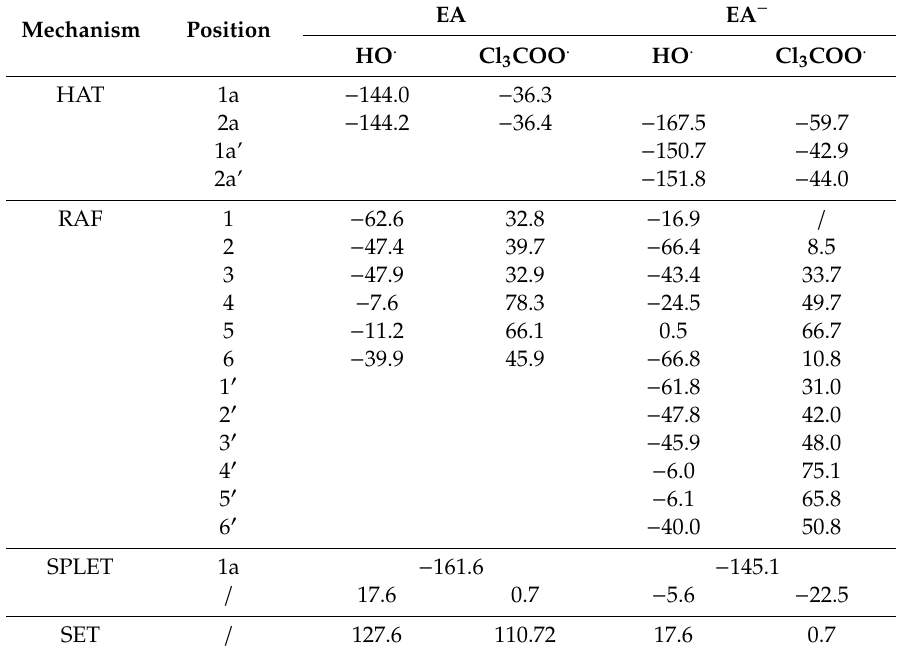
Table 1. Gibbs energies ∆ G r (kJ mol − 1 ) of the reactions of ellagic acid (EA) and its monoanion (EA − ) with HO • and Cl 3 COO • ; HAT, RAF, SPLET and SET denote hydrogen atom transfer, radical adduct formation, sequential proton loss electron transfer and single electron transfer mechanisms, respectively. Mechanism